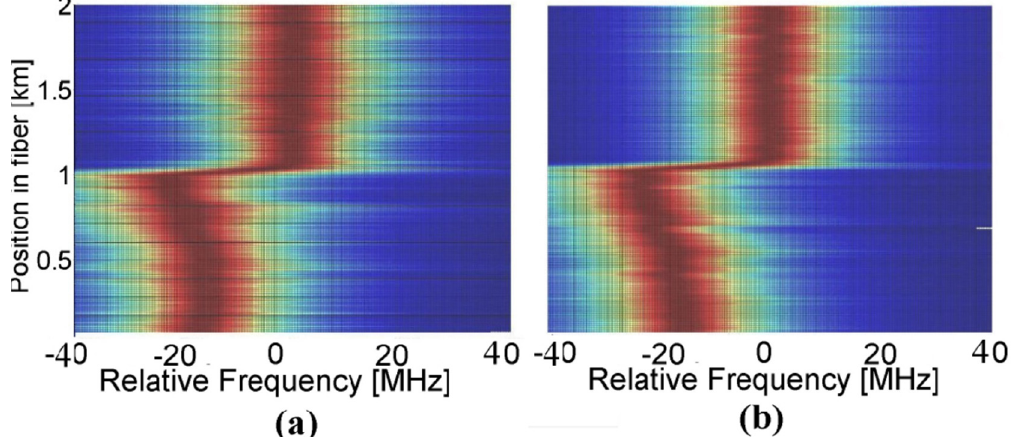
Figure 18. Measurement of the BGS along a 2-km FUT using ( a ) the frequency-sweep method, with 30 frequency tones spanning 90 MHz, reconstructed at a spatial resolution of 50 m; or ( b ) Using a classical BOTDA with 3MHz sweeping step [63].